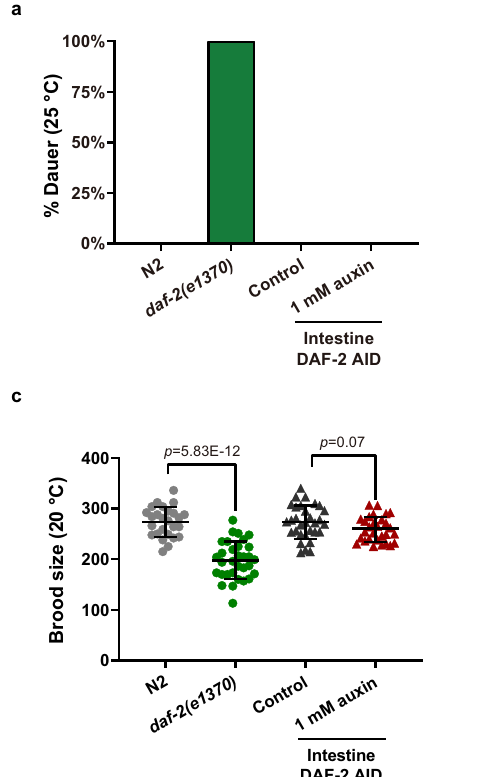
Fig. 5 | Intestine-speci fi c degradation of DAF-2 had no adverse effect on development and reproduction. a Intestinal degradation of DAF-2 did not cause dauer arrest at 25°C. b The intestinal DAF-2 AID worms developed faster than the daf-2(e1370) worms. Data are represented as mean±SEM of three biological repli- cates. c The brood size of intestinal DAF-2 AID worms is comparable to that of the control animals. Data are represented as mean±SD of two biological replicates.